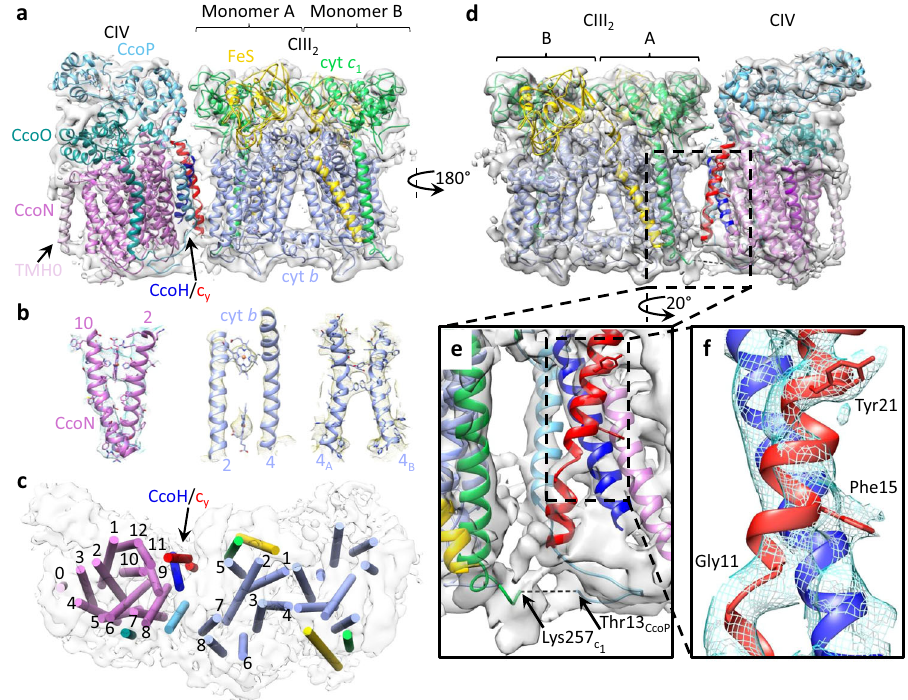
Fig. 2 Cryo-EM structure of CIII 2 CIV. a The structures of CIII 2 (PDB: 6XI0) and the homology model of R. capsulatus cbb 3 -type CIV were fi tted into the cryo-EM map SC-2A (gray), depicted as a side view. All subunits are colored and labeled as in Fig. 1, and the arrow at the edge of CcoN of CIV is for the extra N-ter TMH (TMH0, light purple) speci fi c to R. capsulatus . b Representative regions of the cryo-EM map showing map quality and model fi tting. The TMH2 and TMH10 of CcoN show heme b and some bulky side chains. The protein backbone and hemes b L and b H are resolved between cyt b TMH2 – TMH4 (compare to Fig. 3b, CIII 2 map at 3.3 Å). Large side chains are visible between the TMH4s of CIII 2 monomers A and B (4 A and 4 B ). c Top view of CIII 2 CIV with TMHs depicted as cylinders and colored as in a . The TMHs of cyt b (only CIII 2 monomer A) and CcoN of CIV are numbered, and the TMHs of the FeS protein (yellow), cyt c 1 (green), CcoO (dark green), CcoP (light blue), CcoH/ c y (blue/red with an arrow), and CcoN TMH0 (light purple) are shown. d 180° rotated view for the back view of CIII 2 CIV interface. The two extra TMHs at the interface are those of CcoH (blue) and cyt c y (red). e Enlarged view of CIII 2 CIV interface. The view is slightly rotated relative to d for better visibility of CcoP TMH in the background (light blue). CcoN TMH9 is next to CcoH and cyt c y TMHs. The fusion region between cyt c 1 and CcoP is indicated at the bottom, with cyt c 1 C-ter (green) and CcoP N-ter (light blue) with their respective end residues (Lys257 c1 and Thr13 CcoP ) (only resolved portions). The 12 N-ter CcoP residues connecting these two chains (dashed line) are not resolved. f Enlarged view showing close interaction between CcoH and cyt c y TMHs. Characteristic features of cyt c y TMH (NH 2 -Gly11xxxPhe15xxxxxTyr21-COOH) are used to determine the registration, with the helix break induced by Gly11, and bulky side chains for Phe15 and Tyr21 clearly